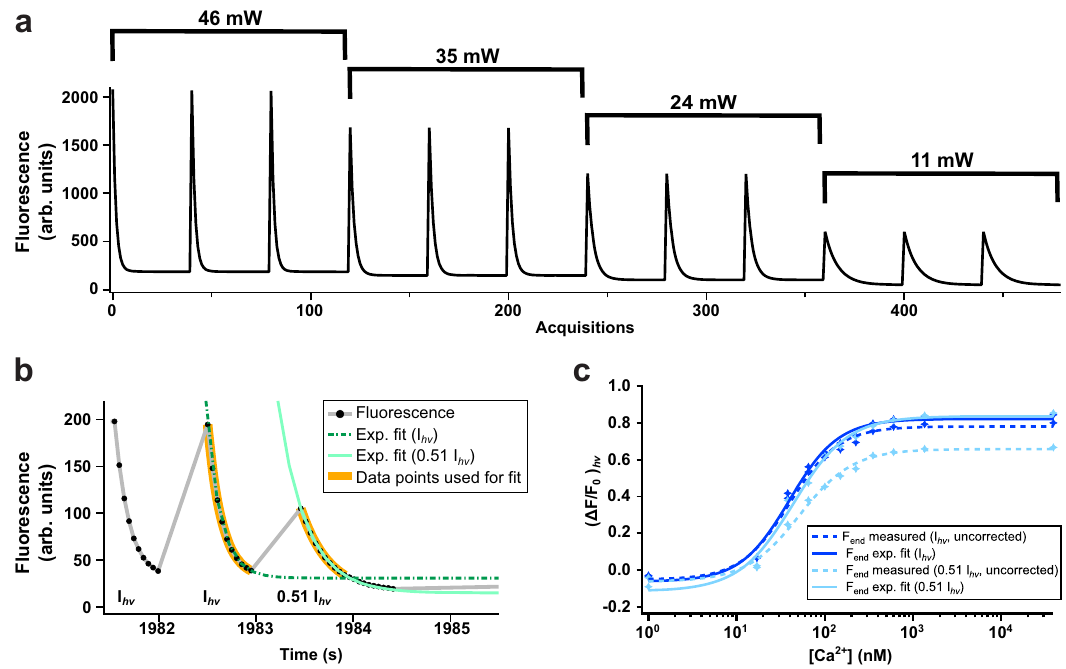
Fig. 5 Intensity-independence of PEAQ biosensing. a Raw fl uorescence traces obtained on puri fi ed GCaMP6s-Q protein at 39 μ M free Ca 2 + with varying powers of cyan irradiation. Full data including other Ca 2 + concentrations is shown in Supplementary Fig. S20. b Raw fl uorescence trace (black) of a representative GCaMP6s-Q-expressing Hela cell at high Ca 2 + concentration during photoswitching. Off-switching was achieved via either 10 acquisitions with 47 mW cyan excitation (I h ν ), or 20 acquisitions with 24 mW cyan excitation (0.51 I h ν ). Green dashed lines show the exponential fi ts of the off- switching decays. The thick orange bands indicate the 10 data points used for fi tting. c Ca 2 + titration of GCaMP6s-Q expressed in a representative HeLa cell. ð Δ F = F 0 Þ was calculated using either F end measured after ten acquisitions, or an F end parameter obtained from the plateau of an exponential fi t. hv `Uncorrected' indicates calibration curves that were obtained without exponential fi tting. For other curves the F end signal was determined using the exponential fi t-based